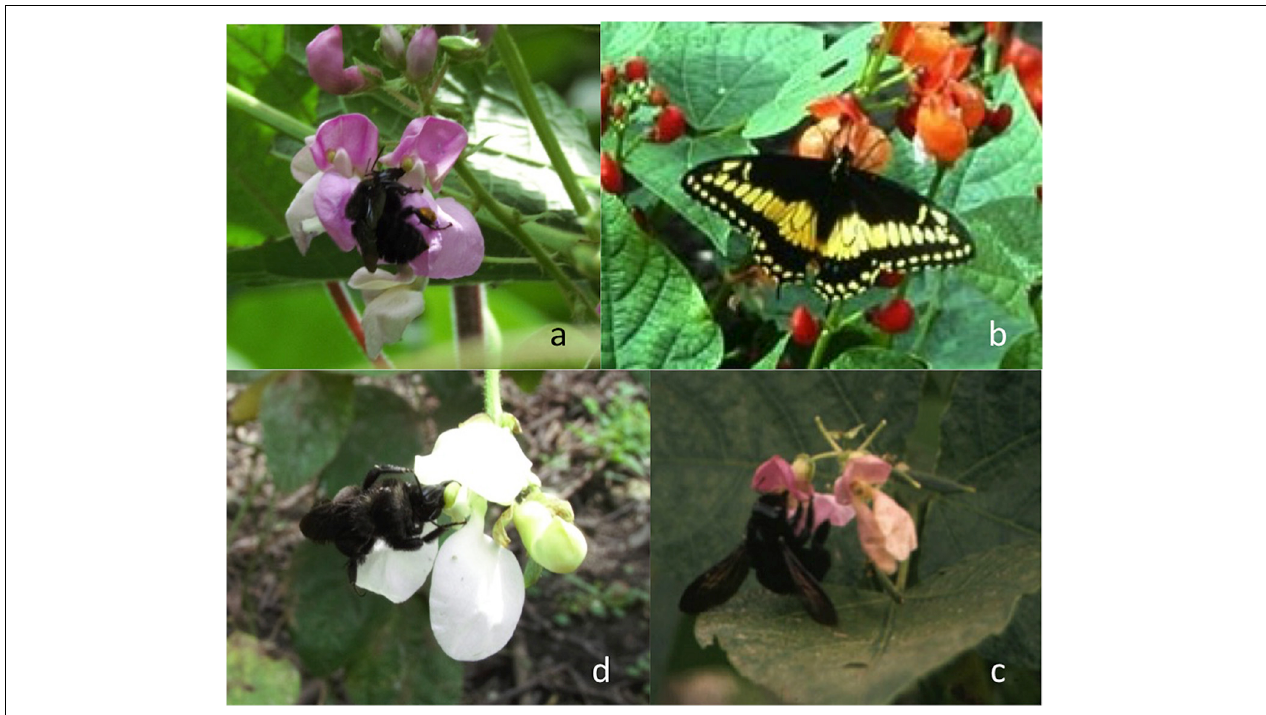
FIGURE 4 | Wild insects pollinating flowers of (clockwise from upper left): (a) dumosus ; (b) coccineus , and (c,d) vulgaris . Note that in (a) and (d) the wild bumblebees have a weight problem to push the left wing downward (the bumblebee in (d) performing better and being rewarded by the stigma on its face), while in contrast in (c) the heavy carpenter bee needs the two wings to keep its balance. In (b) a swallowtail Papilio just uses the two wings as support while sucking the nectar (photo credit: (a) and (d) J. Gereda, Tenerife, Valle del Cauca, Colombia, 2020; (b) D.G. Debouck, Popayán, Cauca, Colombia, 1978; (c) same,